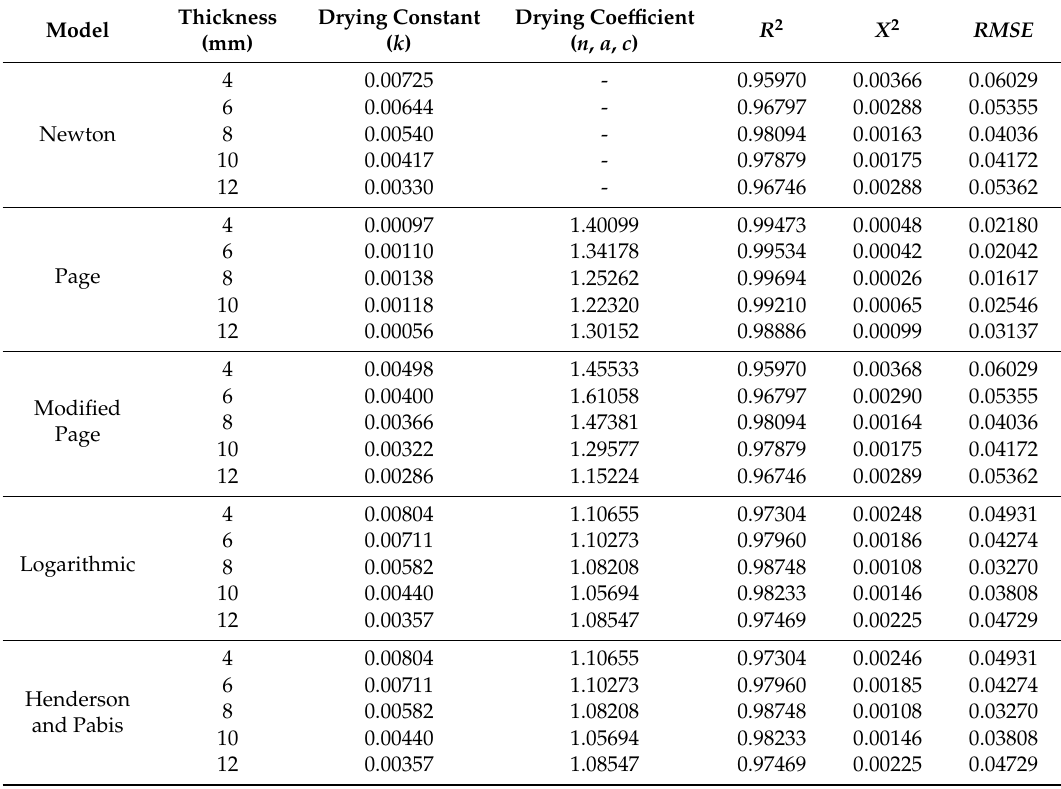
Table 4. Summary of the regression analysis of apple slices with 4, 6, 8, 10 and 12 mm thicknesses at 50 ◦ C and air flow velocity 1.1 m / s.